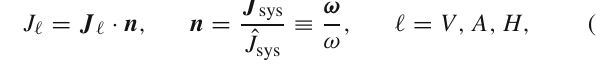
¯ j ), its chirality (distinguished between right-chiral R